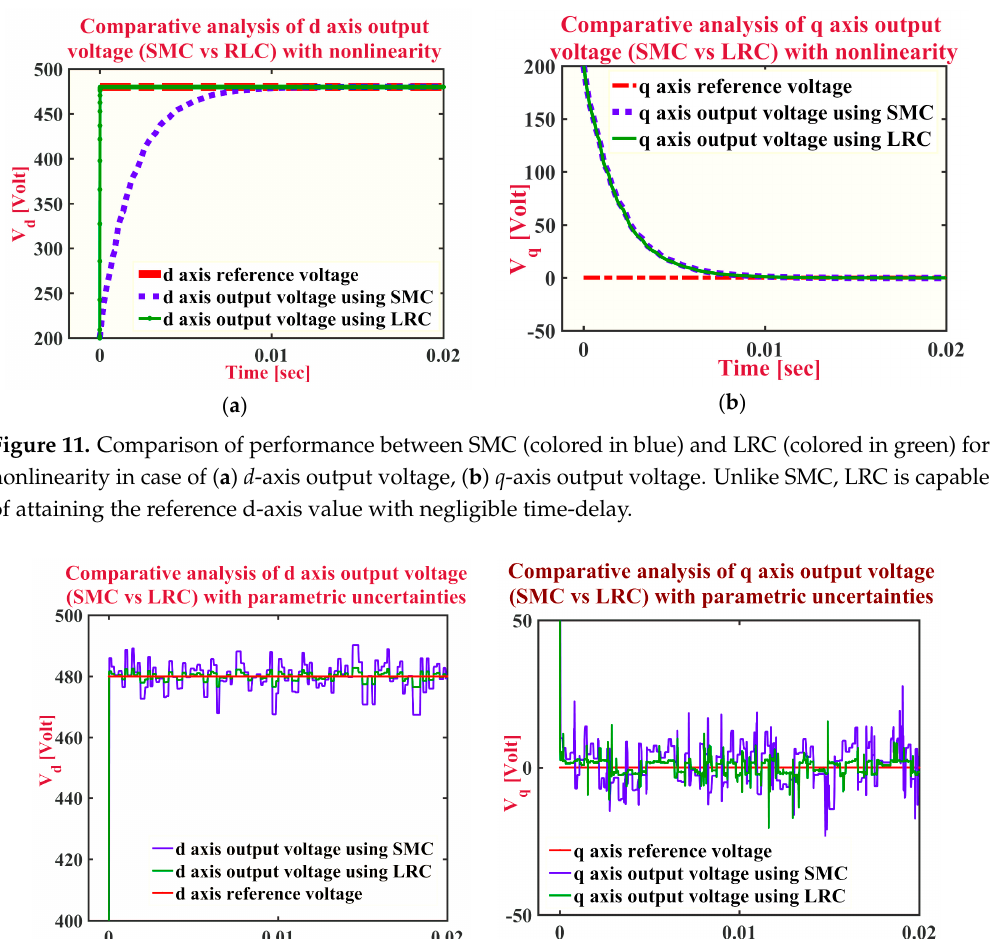
Figure 10. Comparison of performance between SMC (blue colored) and LRC (green colored) for very noisy environment in case of ( a ) d-axis output voltage; ( b ) q-axis output voltage considering CPL power variation and parametric uncertainties. LRC controller shows far better performance than SMC, as the latter shows high fluctuations from the reference voltage, while LRC stays close to it.